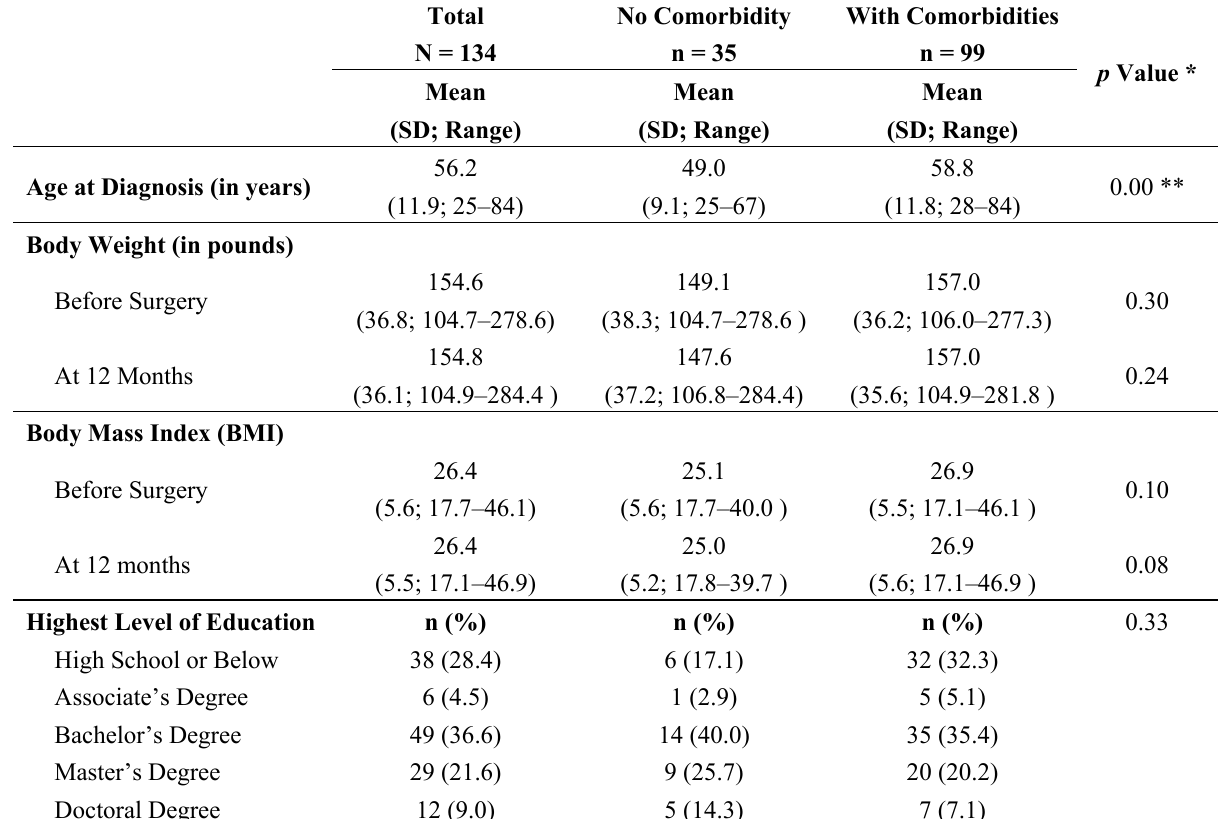
Table 1. Demographic and Clinical Characteristics of